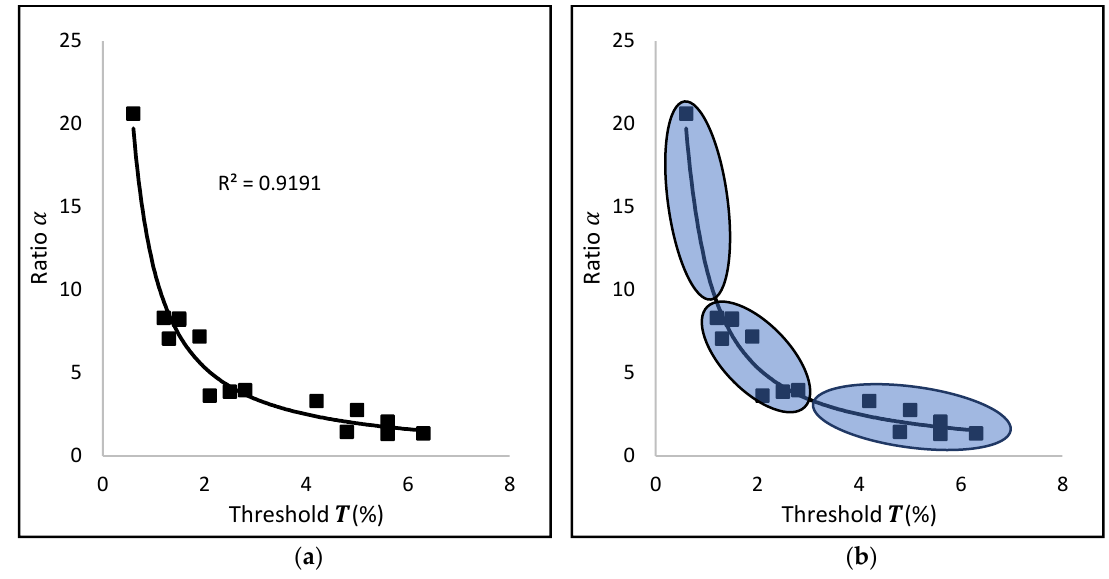
Figure 7. Threshold T α determination using the relationship between the ratio ( α ) and optimal mean threshold ( T ). ( a ) the relationship between α and T ; ( b ) classification of α . Table 2. The results of α , range of optimal T , and mean optimal T for all 15 sampling points on 31